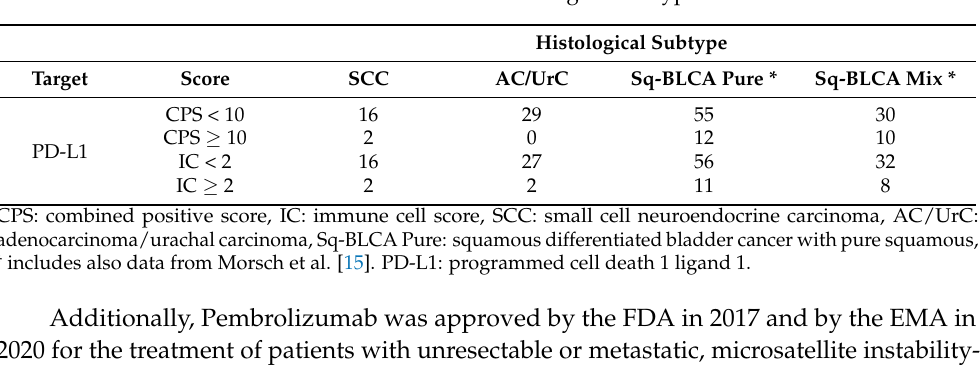
Figure 1. PD-L1 expression and microsatellite instability in different nonurothelial subtypes of bladder cancer. ( A ) Hematoxylin and eosin staining (HE) and immuno-histochemical anti-PD-L1 staining of SCC ( i , ii ), AC/UrCs ( iii , iv ), and Sq-BLCA ( v , vi ) tissues, respectively. Scale bar: 50 µ m. ( B ) Different allele size patterns in cancer tissue compared to normal tissue (loci: BAT25 and BAT26) confirmed micro-satellite instability for a Sq-BLCA patient showing loss of mismatch repair protein expression. ( C ) Single nucleotide variations (SNVs) and copy number variations (CNVs) of mismatch repair (MMR) genes involved in microsatellite instability in different subtypes of bladder cancer (TCGA dataset). Table 1. Immunohistochemical results of PD-L1 in histological subtypes of bladder